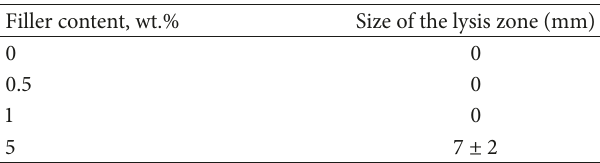
Table 7: Biostability of the HEC/organobentonite composite films against molds.